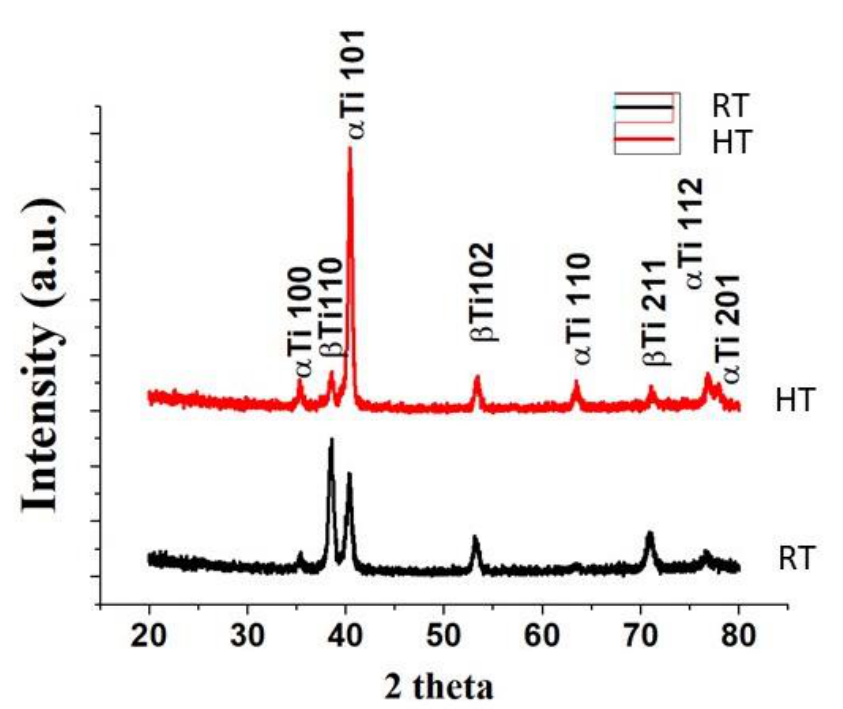
Figure 9. XRD diffractogram of the HT and RT etched surface of the Ti6Al4V alloy. In Figure 11, the SEM morphology of cells is shown after three days of cell culture. All three surfaces displayed a well-spread morphology. However, the machined on showed no filopodia, whereas the RT etched surface exhibited small filopodia extension and the HT etched surfaces showed the communication of cells through larger filopodial extensions, as shown in Figure 11F. Cell proliferation was studied on days 3 and 7 of cell culture. Figure 12 shows the bar diagram of relative optical density of MG 63 cells on the machined, RT, and HT etched surfaces estimated by the MTT assay. There was a statistically significant increase in the proliferation on the HT etched surface (* p < 0.05) compared to the machined surface on day 7. Figure 13 shows the fluorescent images of live and dead after 24 h of cell culture on the machined and different etched surfaces. Calcein stains live cells as green and propidium iodide (PI) stains dead cells in red. All surfaces showed good cell viability, suggesting a good cytocompatibility of the surfaces. However, cells had more spreading and filopodial extensions on a HT etched surface, similar to the results obtained from FESEM. Figure 14 shows the fluorescent microscope images of cells adhered to different surfaces where the cell cytoskeleton (actin filament) was stained by rhodamine-phalloidin and DAPI stained cell nucleus. There was an increase in cell numbers on the HT acid etched surface compared to the RT etched and machined. On the RT etched surface, actin filaments were spread in irregular directions whereas on the HT etched surface, they run along the long axis of the cell. Cells had a more spread morphology on the HT etched surface compared to the RT etched and machined